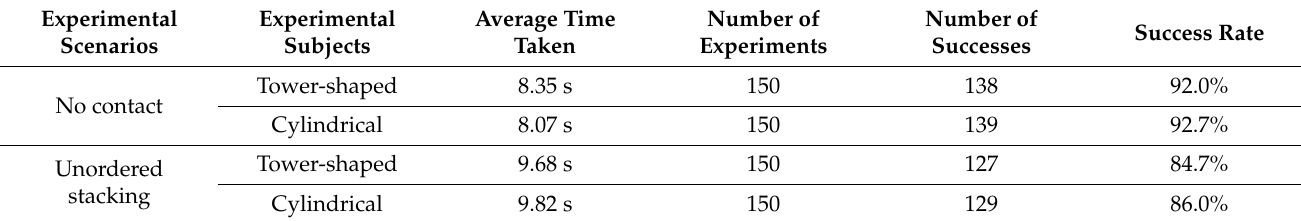
Table 3. Experimental